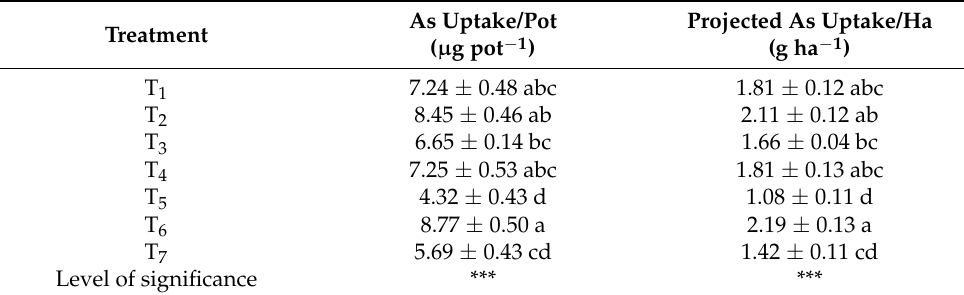
Table 4. Effect of water management on As uptake by rice grain (cv. BRRI dhan28). Treatment